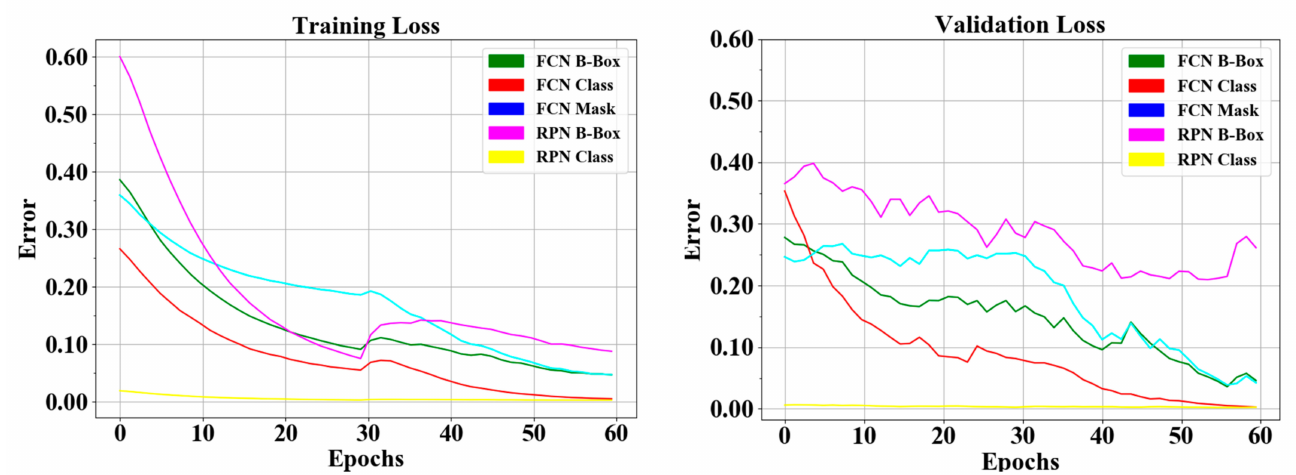
Figure 15. Loss curve of heart defect detection with proposed instance segmentation model. RPNs and FCN loss in training and validation